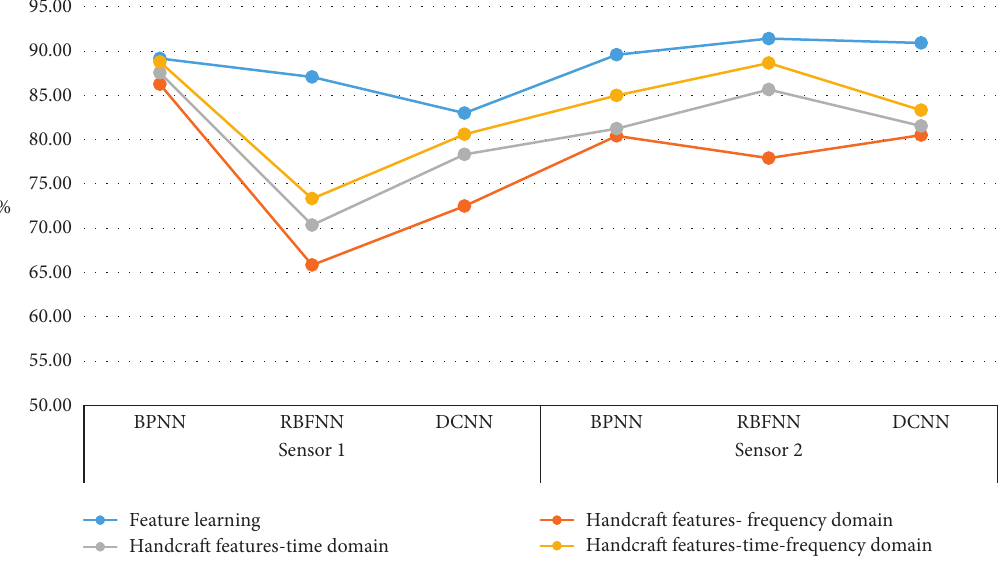
Figure 8: Testing the accuracy of several network models.